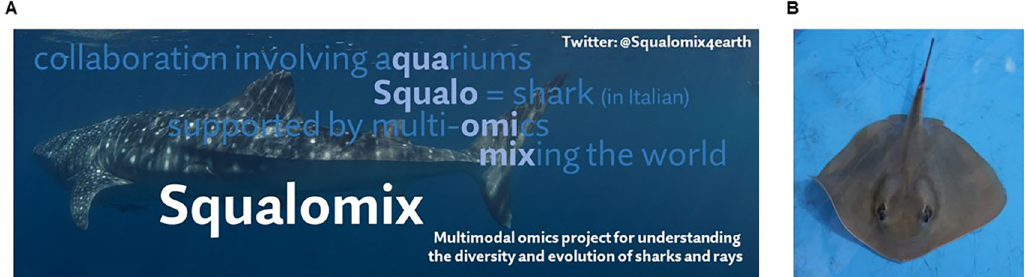
Figure2.SqualomixConsortium. A,Consortiumlogo.B,Oneofthemainstudyspecies,theredstingray Hemitrygon akajei. Photo credit: Itsuki